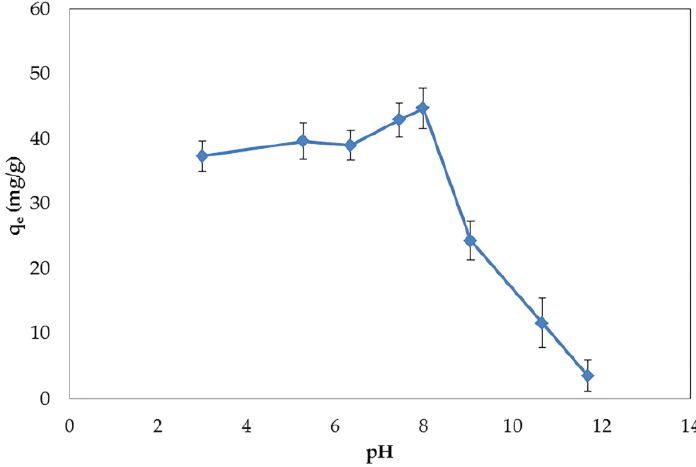
Figure 4. Effect of pH on the adsorption capacity of BPA.